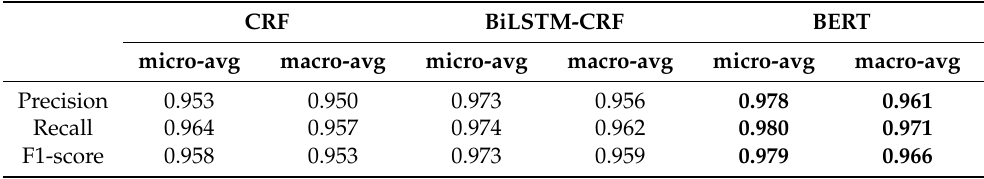
Table 8. Performance of NER models. The best performance is highlighted in bold.